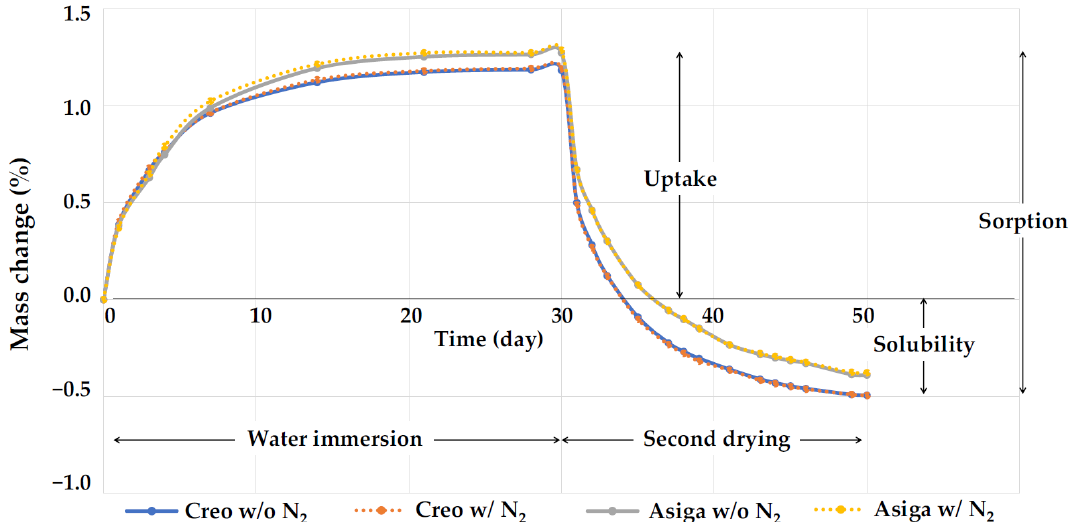
Figure 5. The representative plots of mass changes (%) against time during the water immersion and the second drying procedure. Note the saturation 14 days after water immersion and completion of drying 20 days after drying began in all groups.